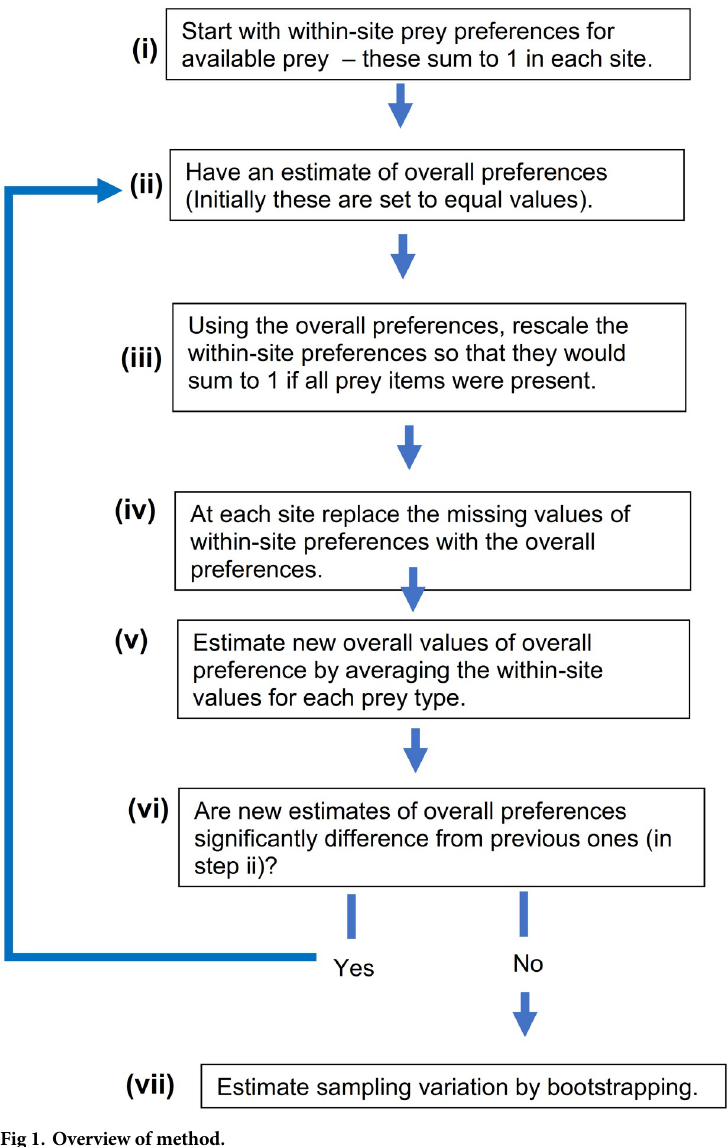
Fig 1. Overview of